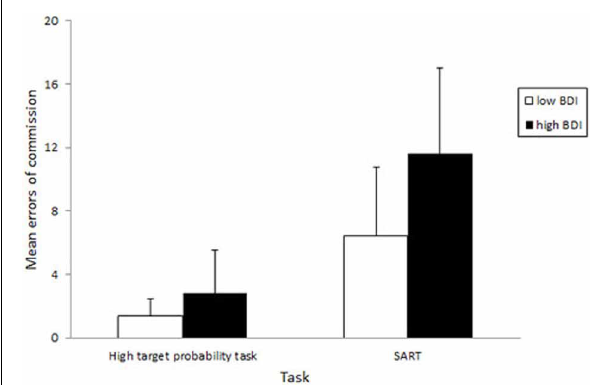
FIGURE 1 | Mean errors of commission on the SART and on a modified version of the task in low and high BDI participant groups. Error bars are 1